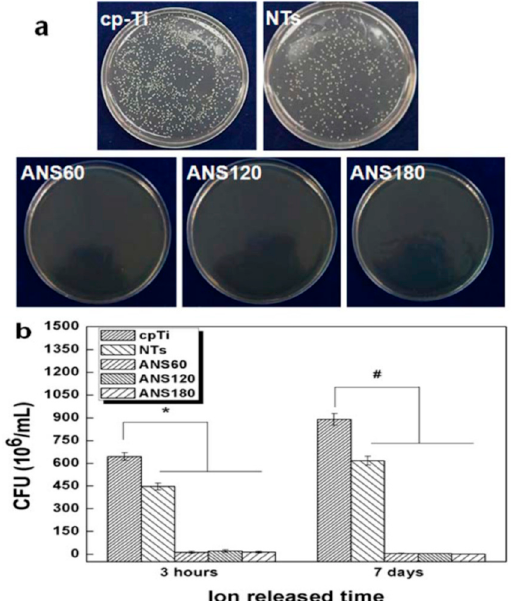
Figure 21. (a) Photographs showing the spread of S. aureus on commercially pure titanium (cpTi), titanium nanotubes (NTs) and Ag-doped TNTs samples. ( b ) Antibacterial efficacy of all samples immersed in PBS for 3 h and 7 d. The error bars are the standard deviation ( n = 5); * denotes p < 0.05 compared with cp-Ti at a 3 h ion extraction time, # denotes p < 0.05 compared with cp-Ti at 7 days ion extraction time. Reproduced with permission from [261]. Copyright Wiley, 2014.